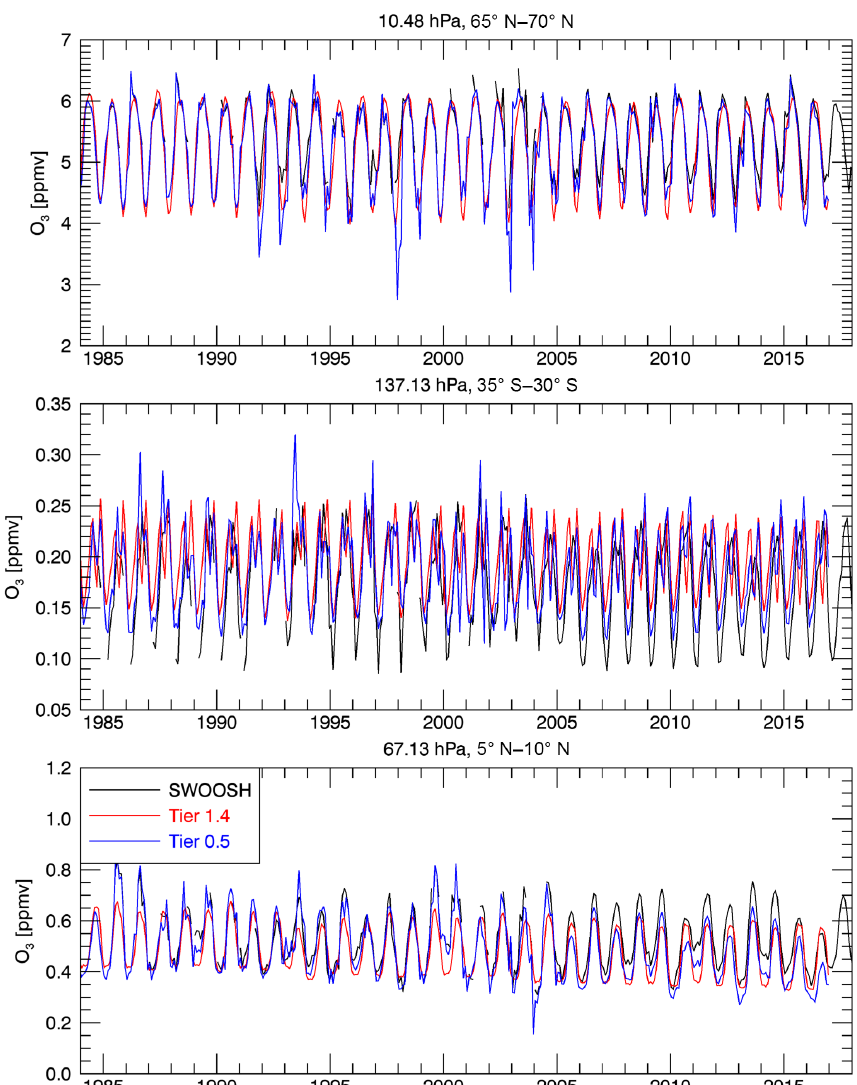
Figure 9. Comparisons between SWOOSH (black line), BSVertOzone Tier 0.5 (blue line), and BSVertOzone Tier 1.4 (red line) for three different latitude bands and three different pressure